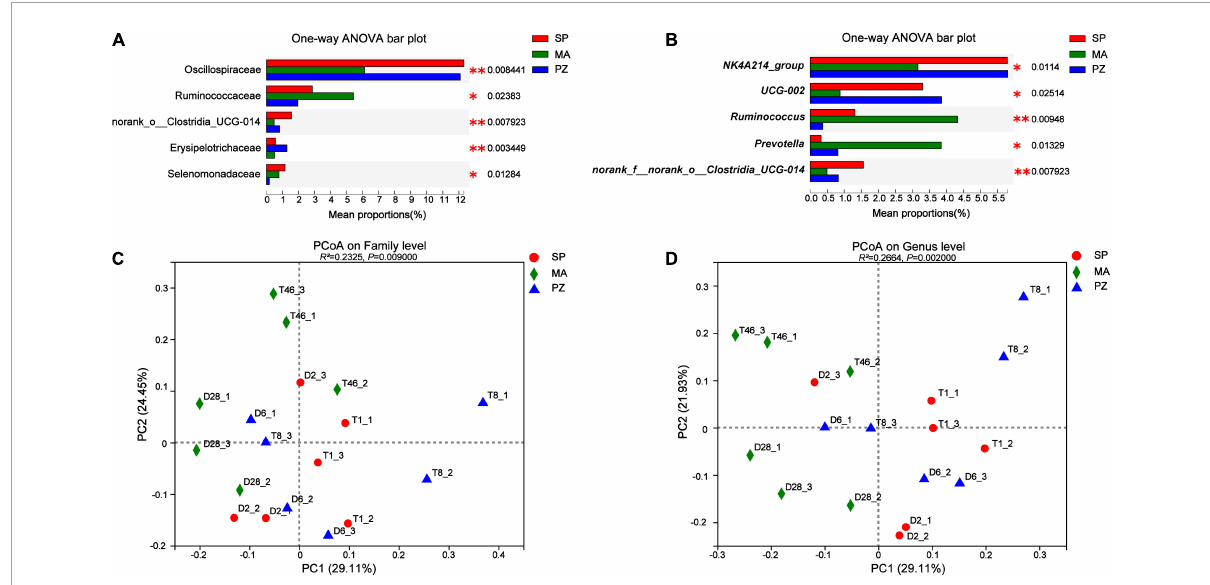
FIGURE5 Analysis and significance test for differences in intestinal bacterial species among different species; (A) family level; (B) genus level; (C) family level PCoA plots; (D) genus level PCoA plots. * P < 0.05 and ** P <